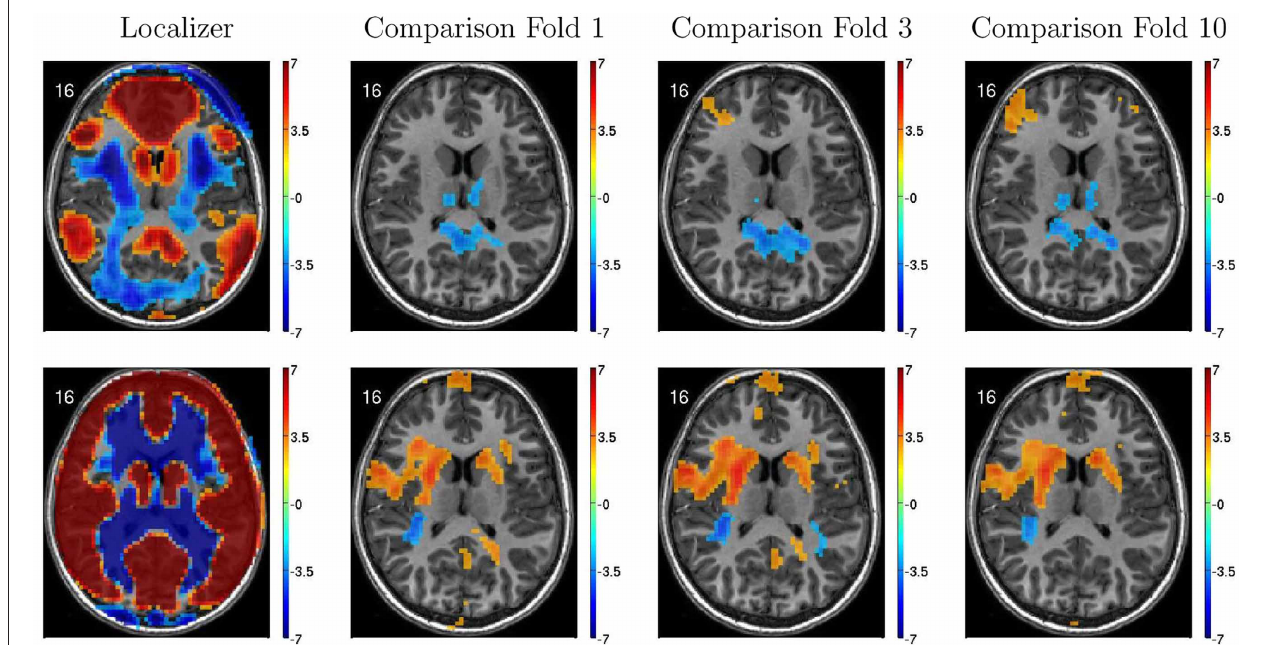
FIGURE 6 | Top-row: Axial slices of default mode network (DMN) localizer map and three patients vs. controls statistical comparison maps computed on different folds of 10-fold cross validation. Each fold omitted from the comparison a different subset of 66 or 67 participants out of the 668 participant Training Dataset. For the localizer map, red/blue regions exhibited weighting significantly above/below zero. For contrast maps, red and blue regions exhibited greater weighting for patients and for controls, respectively. Left side of axial slice represents left side of brain.